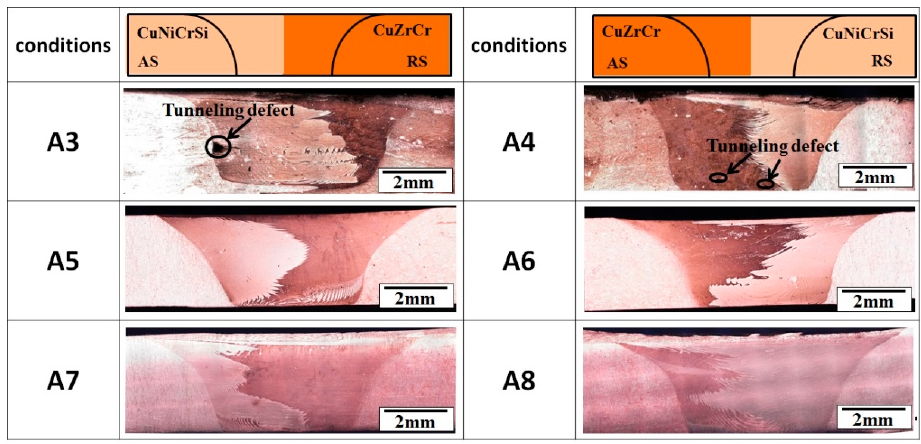
Figure 4. The transverse cross-section macrographs of the welded joints obtained under conditions A3–A8.